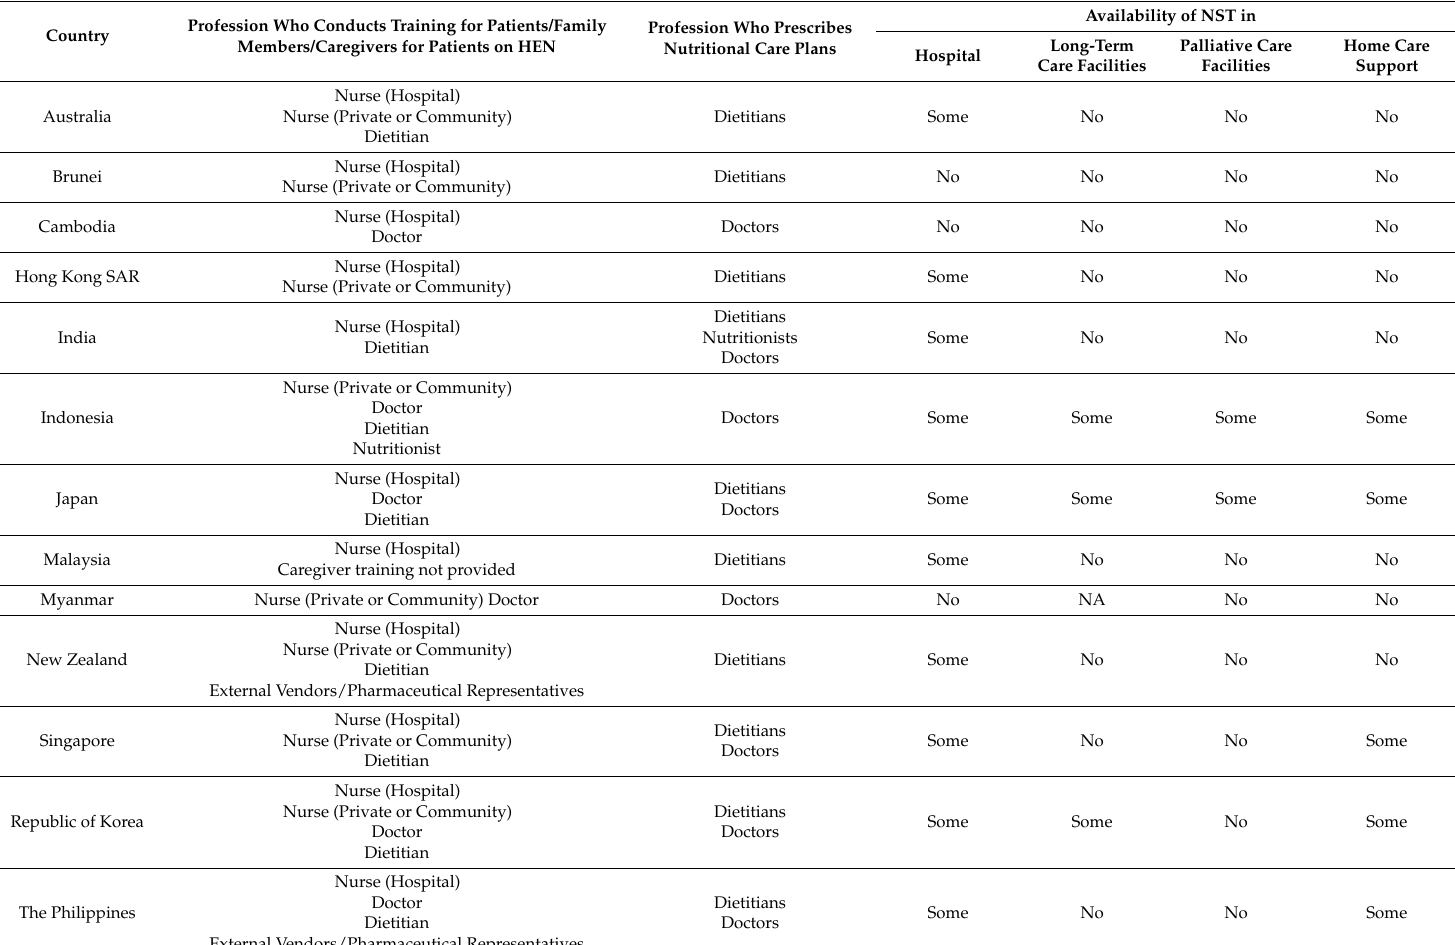
Table 4. Home Enteral Nutrition Practices in Countries Participating in the Survey—Clinical